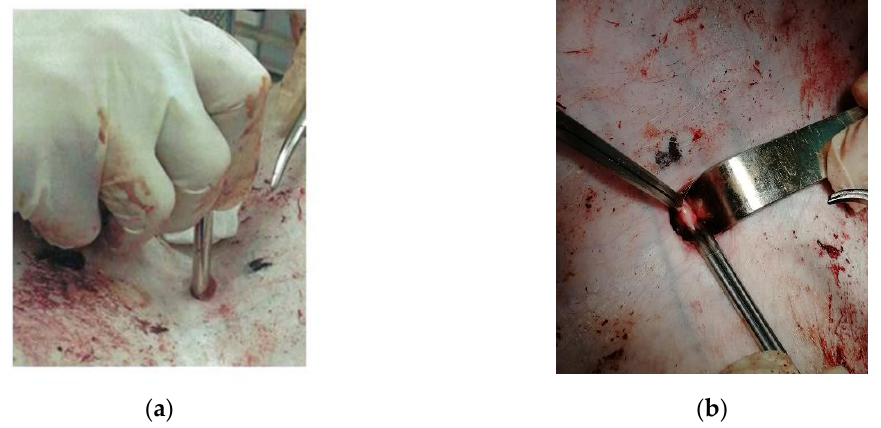
Figure 3. Stages of modeling the damaging of the large vessel (pig’s femoral artery): ( a ) modeling of the wound channel—a soft tissue wound made by stylet trocar; ( b ) the allocation of the femoral artery in the wound.